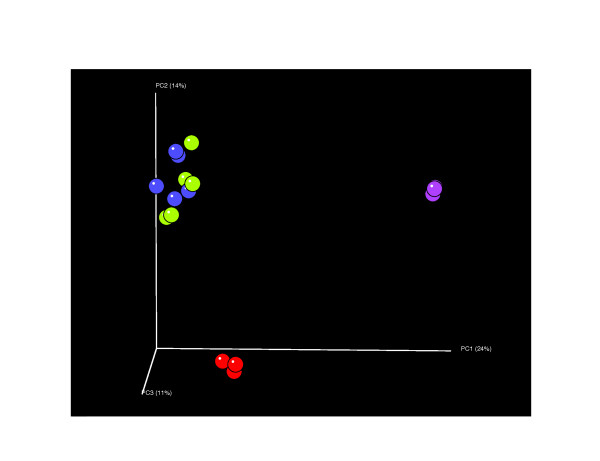
Community analysis using principal coordinate analysis (PCoA) of unweighted UniFrac distance matrix. Across all methodologies assessed, (including the canonical UniFrac beta-diversity analysis), water samples cluster very well, yet the phyllosphere treatments are unable to be differentiated. Displayed color scheme: ps (green), pg (blue), ws (purple), wg (red). Percentage of variation explained by each principal coordinate is shown on respective axes.